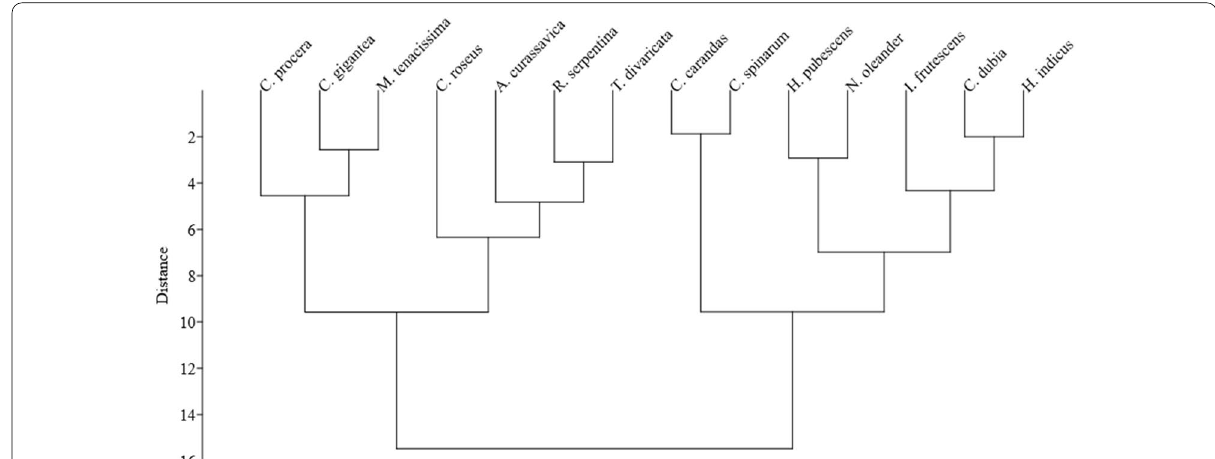
Fig. 4 Cluster analysis dendrogram showing interrelationships between 14 species of family Apocynaceae used in ISM based on 33 morphological, anatomical, and powder characters of the RDS